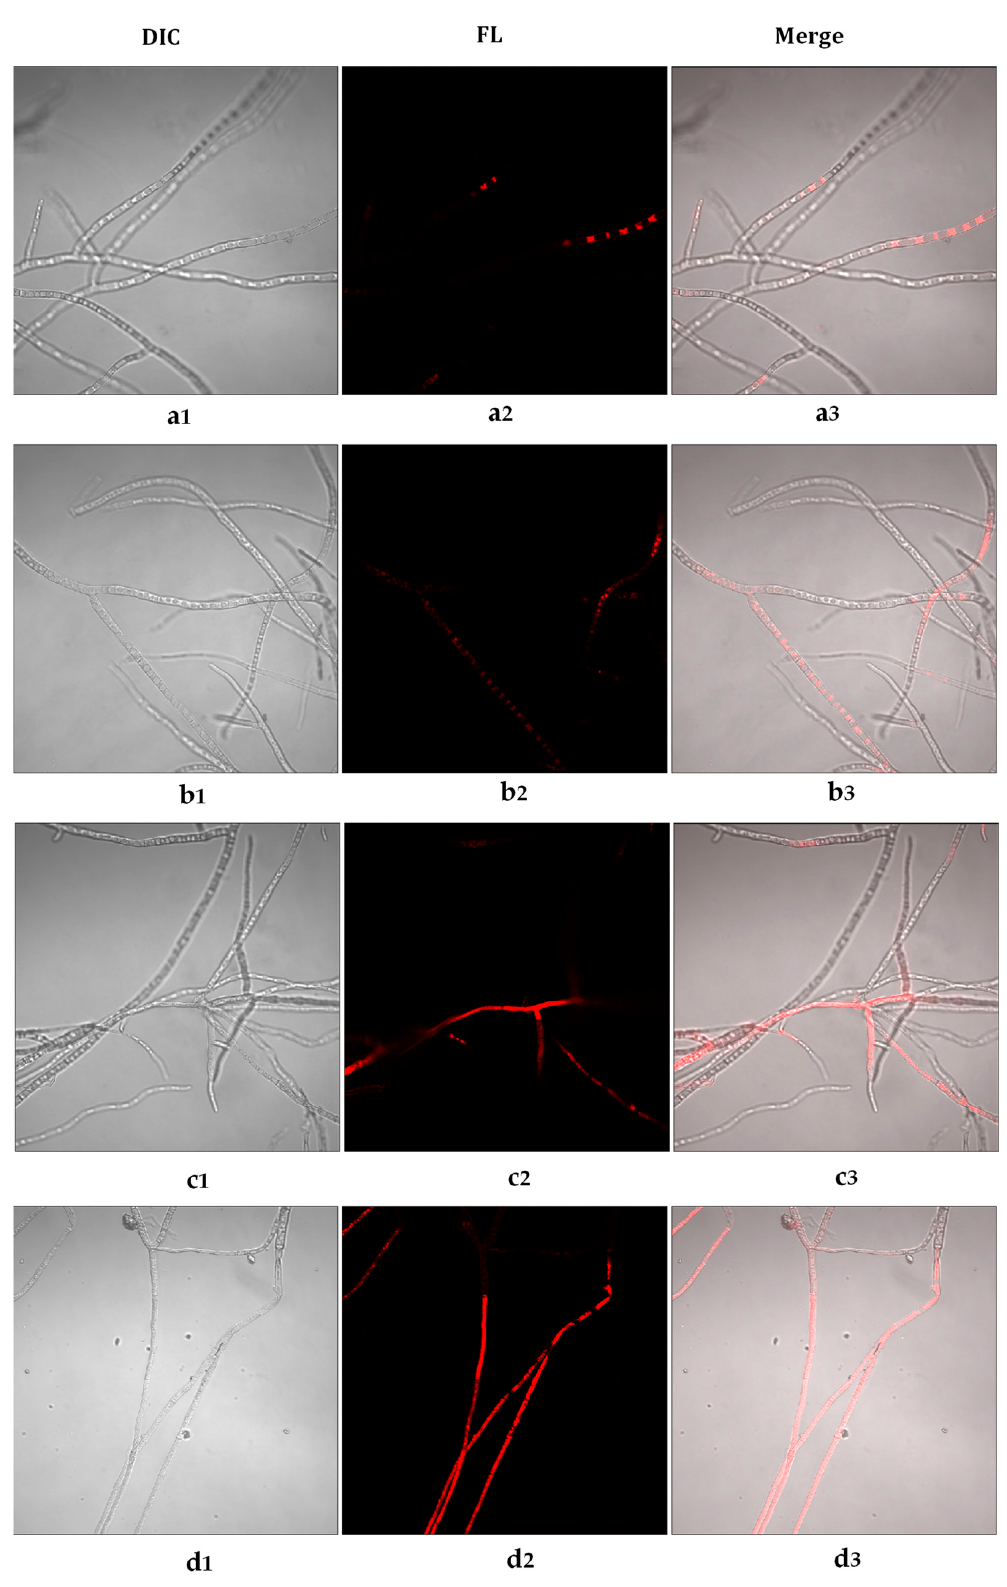
Figure 3. Confocal laser scanning microscopy images of Botrytis cinerea mycelium membrane integrity exposed to control ( a1 – a3 ), Cymbopogon citratus ( Cc , b1 – b3 ), Thymus vulgraris ( Tv , c1 – c3 ), and Origanum heracleoticum ( Oh , d1 – d3 ) essential oil. DIC, differential interference contrast images without fluorescence; FL, red fluorescence images with propidiumiodide (PI) combined with nucleic acid.